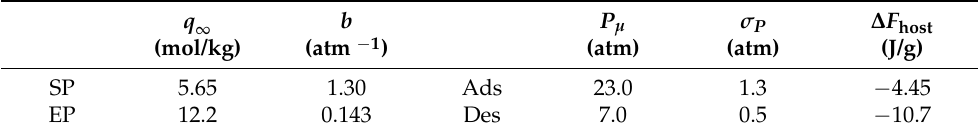
( EP ) − F ( SP ) . host host